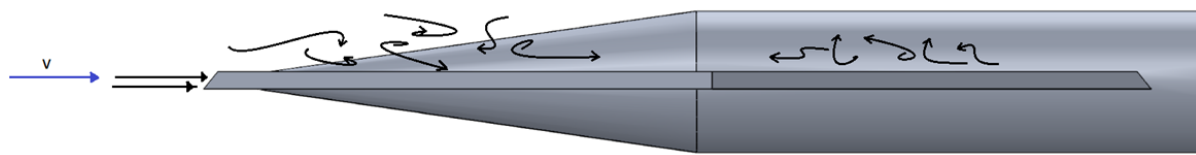
Figure 13. Model of air water flow behavior on the airframe structure with marked water stream velocity (V). A drawing illustrates schematic formation of turbulent flow, seen in Figure 12.